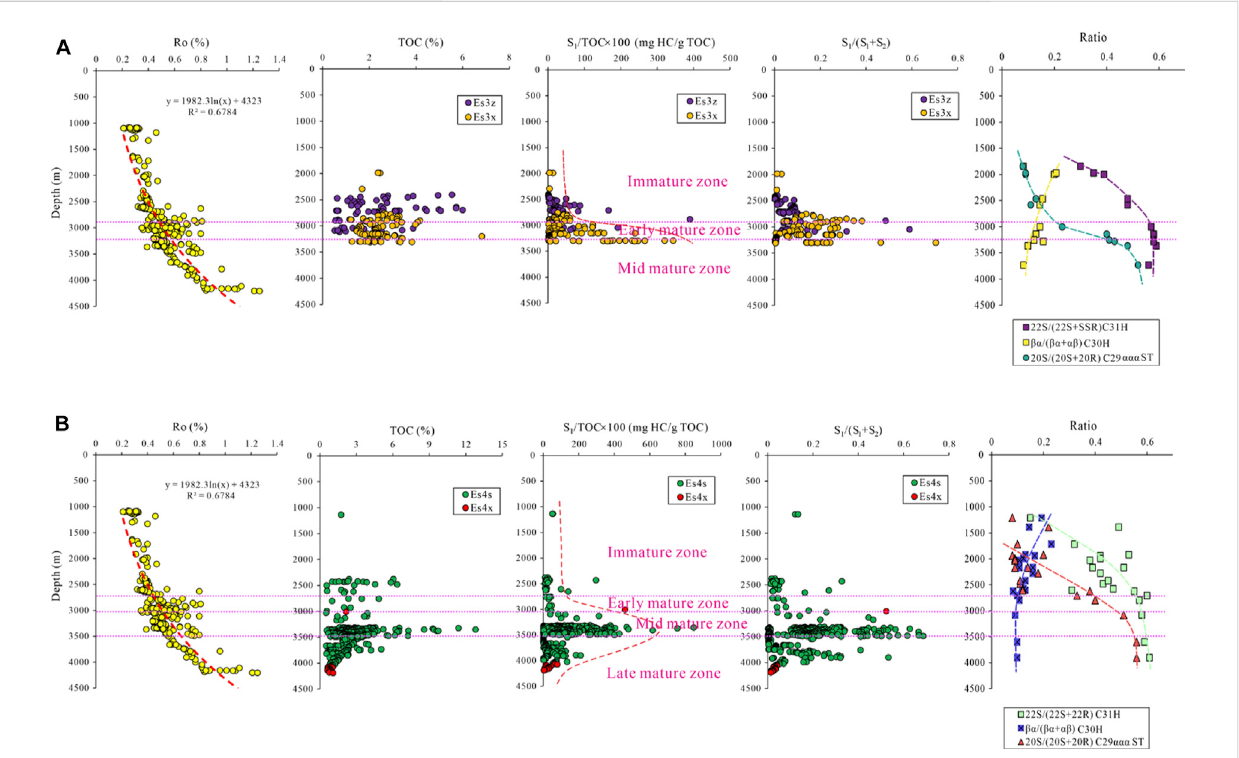
FIGURE 8 Oil generation expressed by %Ro, TOC, S 1 /TOC, S 1 /(S 1 +S 2 ), and biomarker maturity ratios of source rocks with burial depth. The maturity zones are determined by the shape of the curves, and the sterane and hopane ratios of the source rock extracts (Wilhelms et al., 1998). (A) Es3 member. (B) Es4 member.